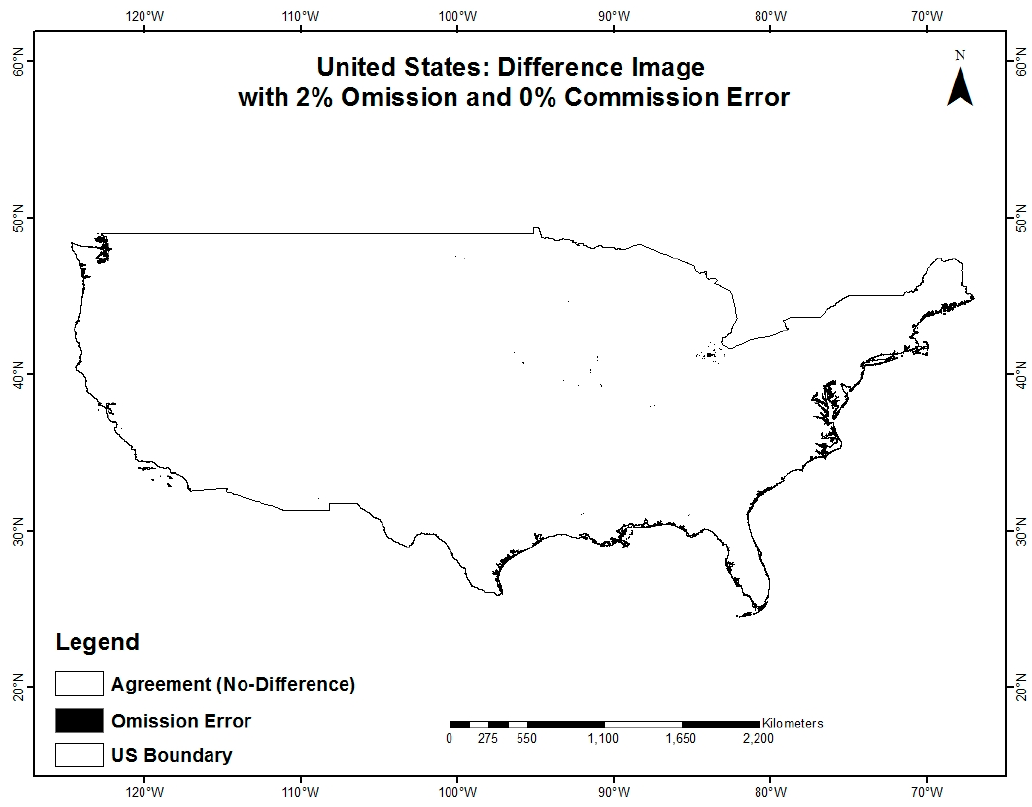
Figure 6 . The difference image derived using reference data and cropland map of the US showing 2% Omission and 0% commission error.